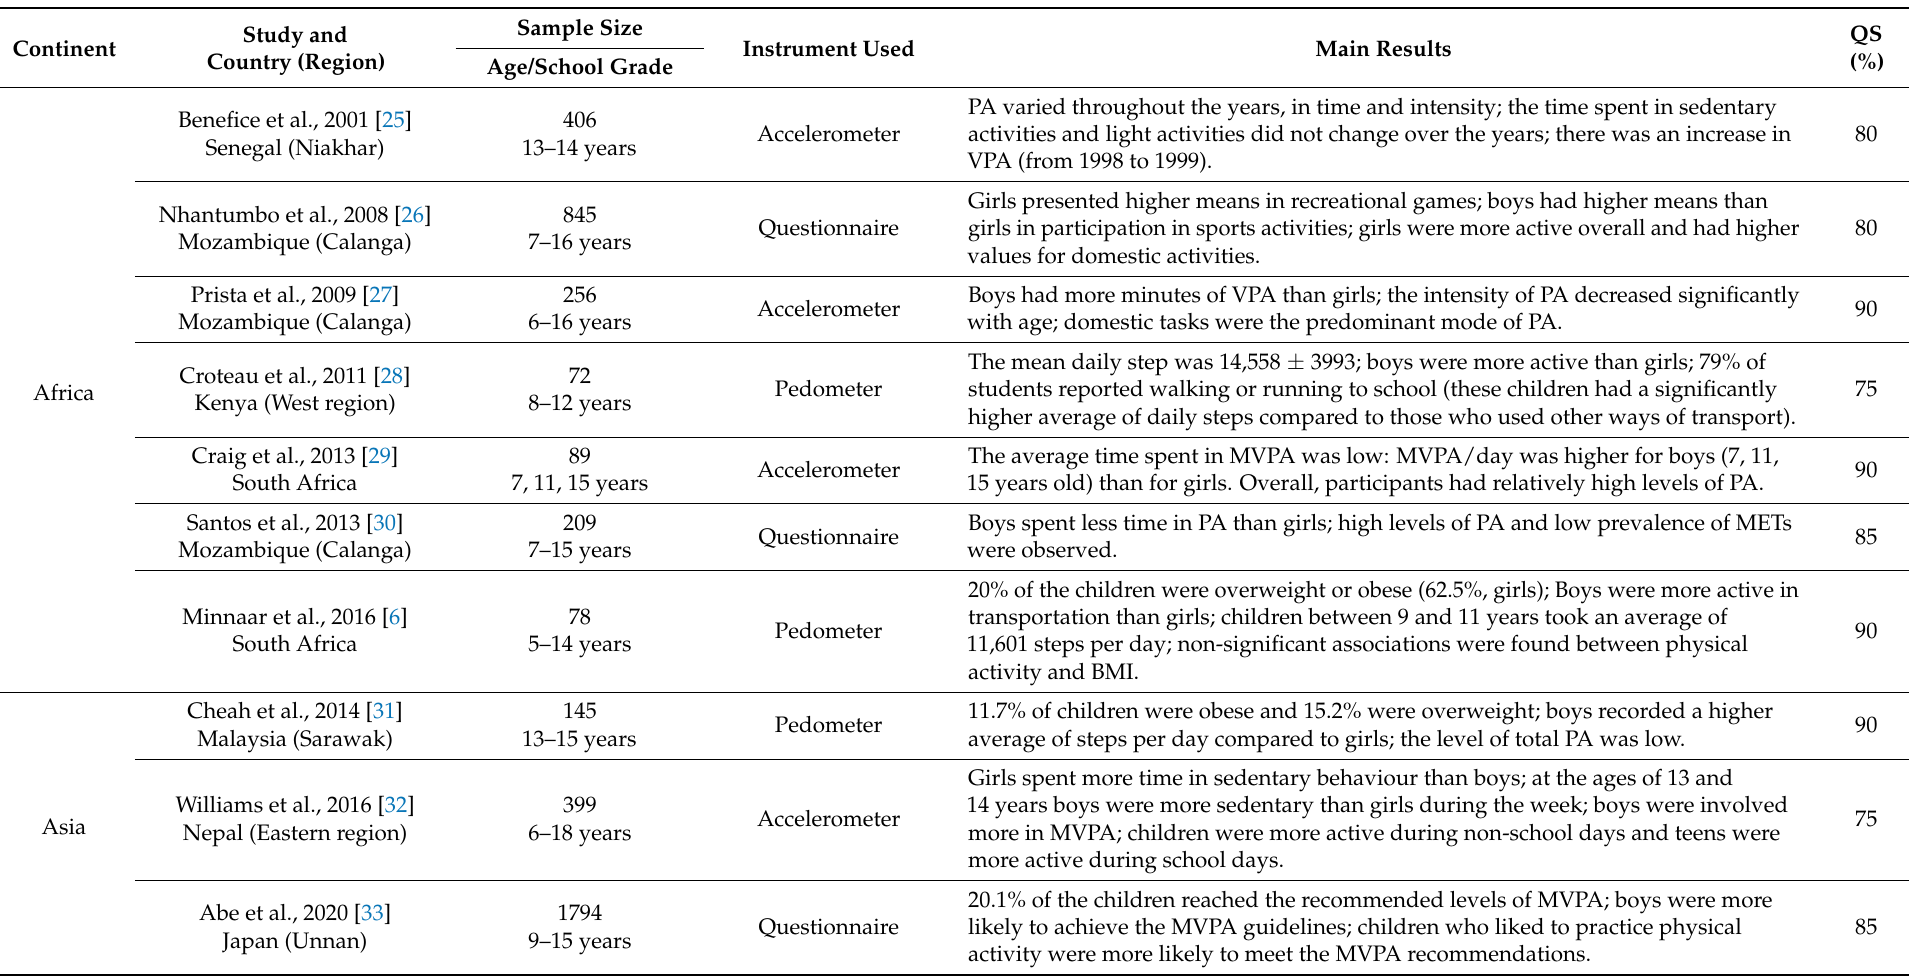
Table 2. Data extracted from articles that sampled only rural children